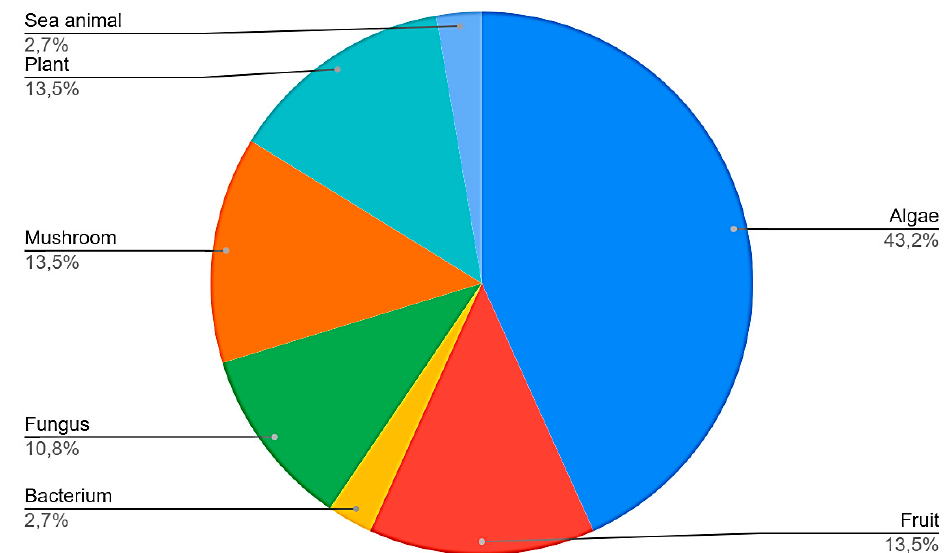
Figure 3. Sources of polysaccharides found in the studies selected in the systematic